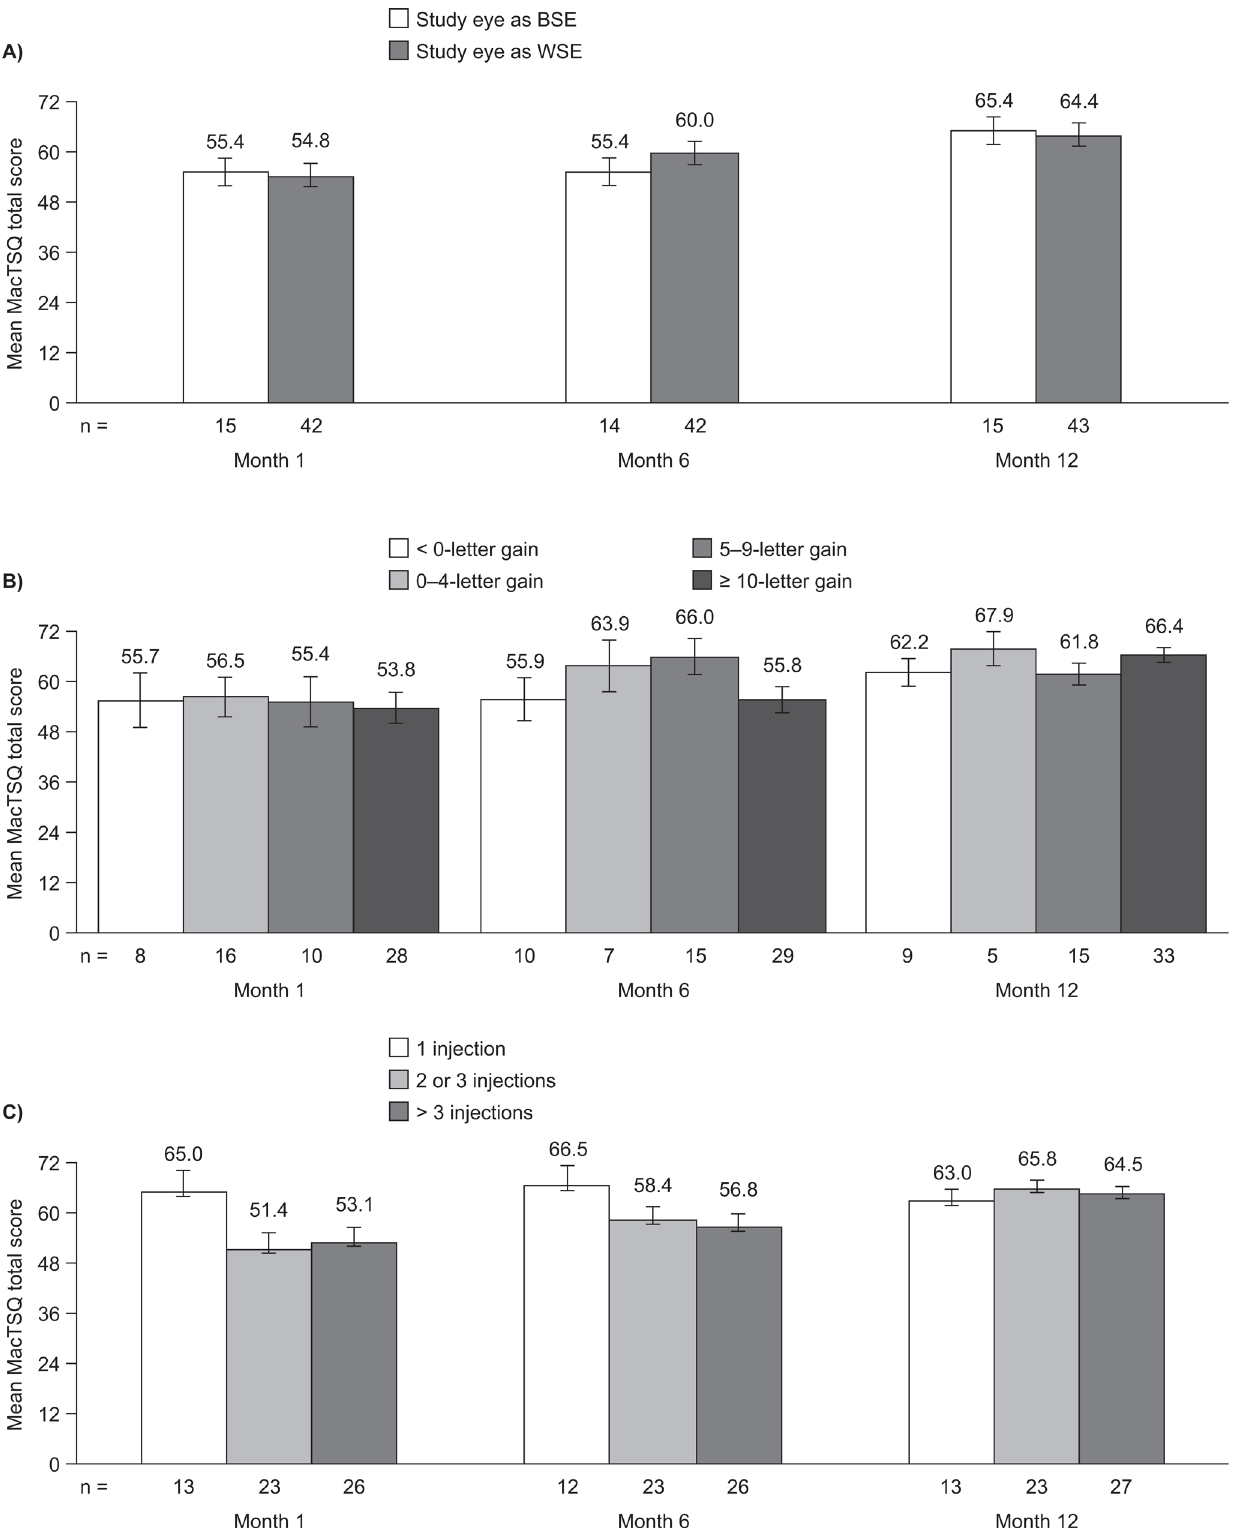
Fig 2. MacTSQ total scores. (A) BSE/WSE, (B) BCVA improvement and (C) number of injections. Data are shown as mean ± standard error. BCVA, best- corrected visual acuity; BSE, better-seeing eye; MacTSQ, Macular Disease Treatment Satisfaction Questionnaire; WSE, worse-seeing eye.